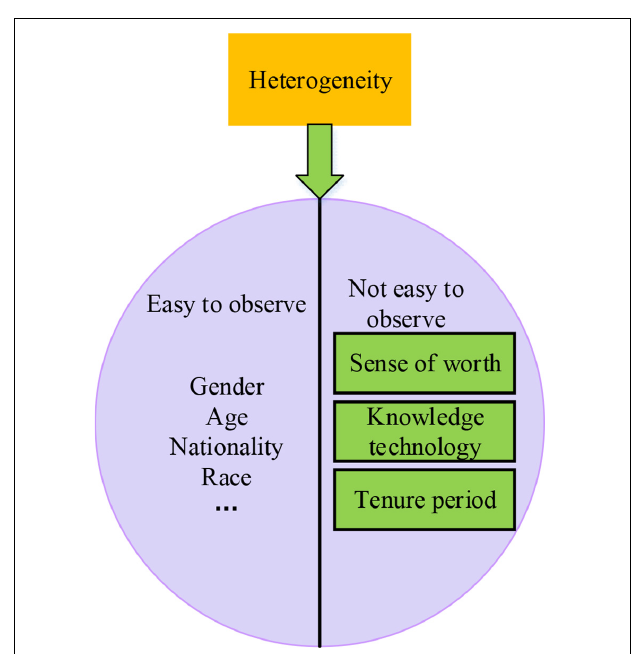
FIGURE 1 | Heterogeneity classification